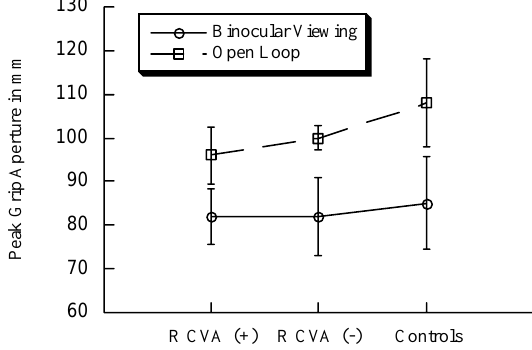
Fig. 1. Overall Peak Grip Aperture for the R CVA patients with and without neglect (R CVA ( + ), R CVA ( − )) and the control group using their right hand. Error bars indicate SE’s. N − = 93mm, SD = 10.6) did not differ from the aperture shown by the controls (mean = 97.3 mm, SD